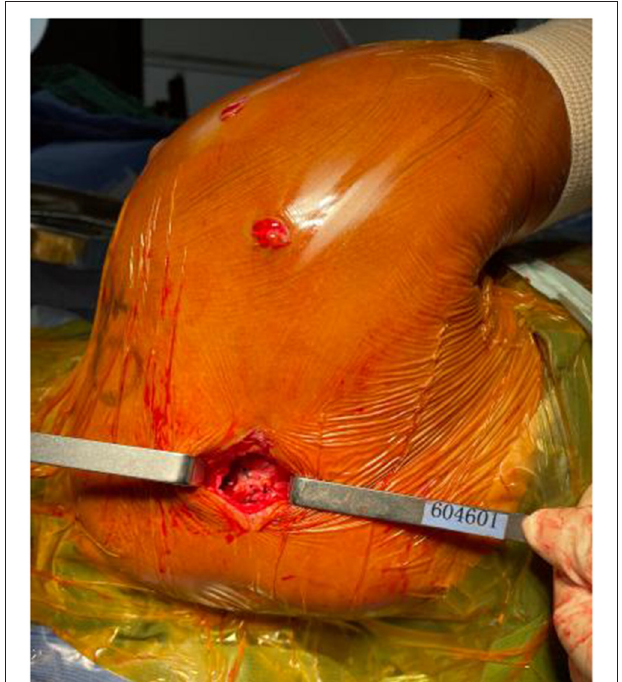
FIGURE 7 | The insertion site of the lower trapezius on the scapular spine was exposed through the posterior scapular incision, dissected, pulled distally, and the free end of the tendon autograft passed across the lower trapezius and